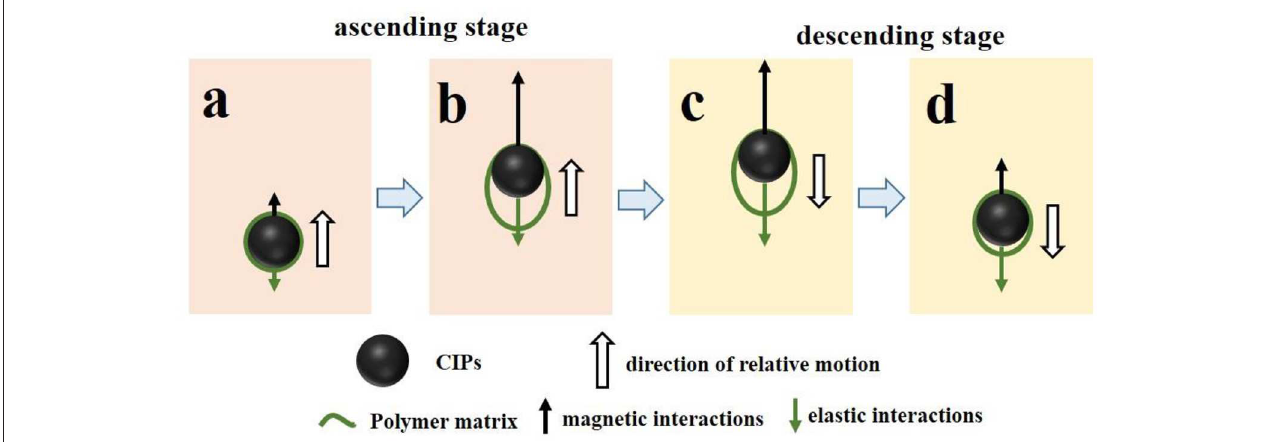
SCHEME 1 | The schematic of the movement of CIP under the ascending and descending magnetic field. (a) ascending stage with a smaller relative displacement; (b) ascending stage with a larger relative displacement; (c) descending stage with a larger relative displacement; (d) descending stage with a smaller relative displacement.